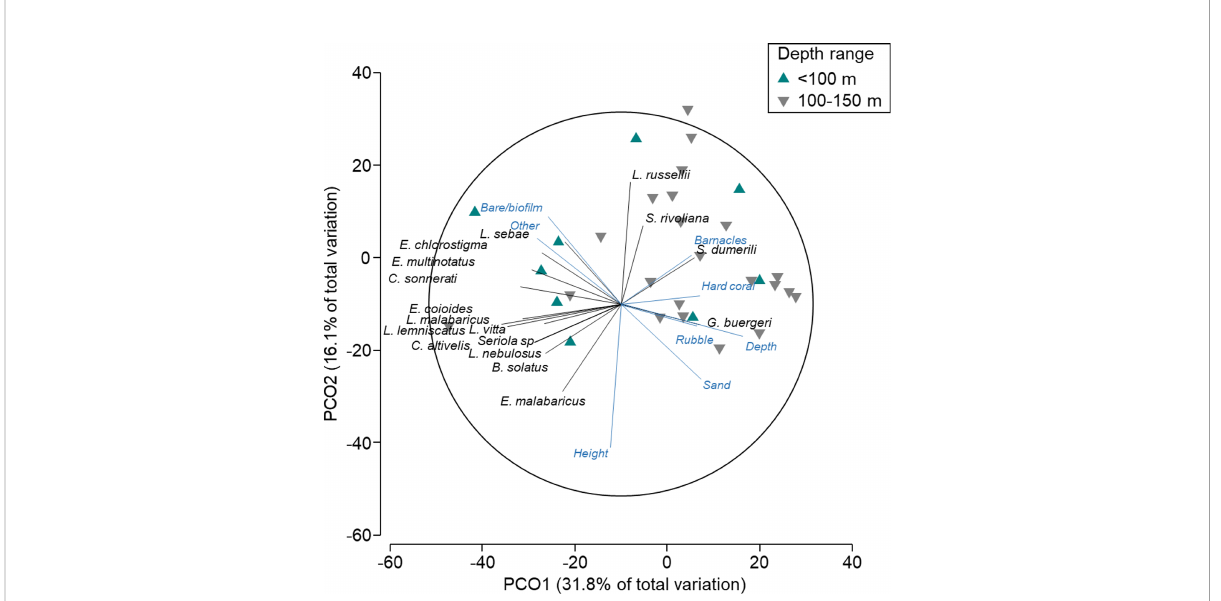
FIGURE 4 Principal coordinates ordination (PCO) on fi shery target species only in depths <150 m (north-west wells). Vectors are displayed and show fi sh species and explanatory variables with Pearson ’ s correlations of |R|>0.3 to one or more axes. Vectors indicate the direction of the relationship, and their length indicates the strength of their effect on the assemblage of fi shery target species.